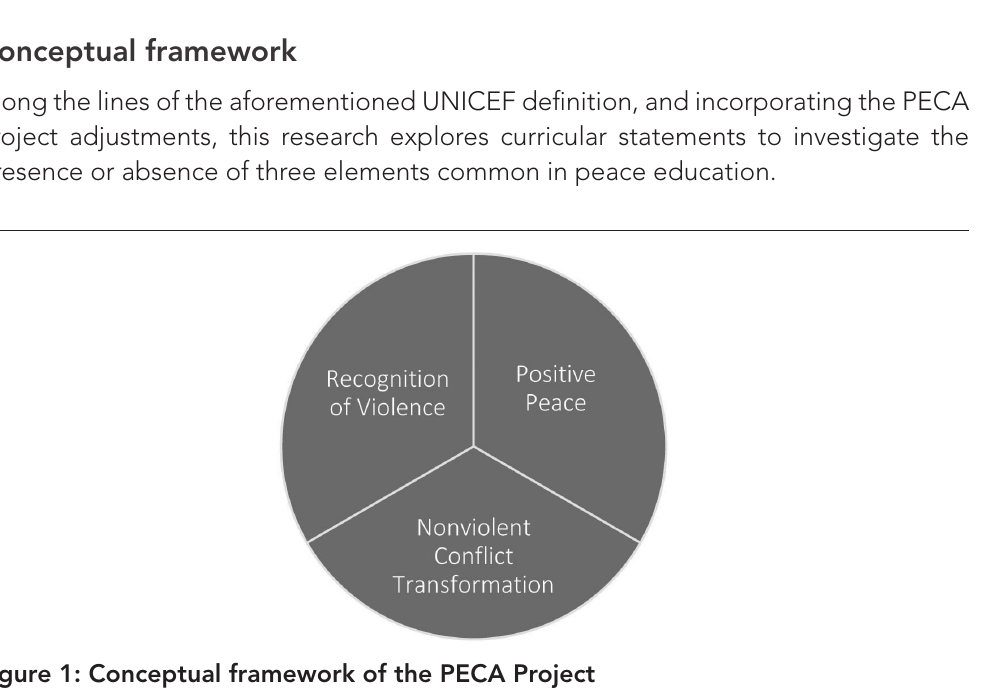
Figure 1: Conceptual framework of the PECA